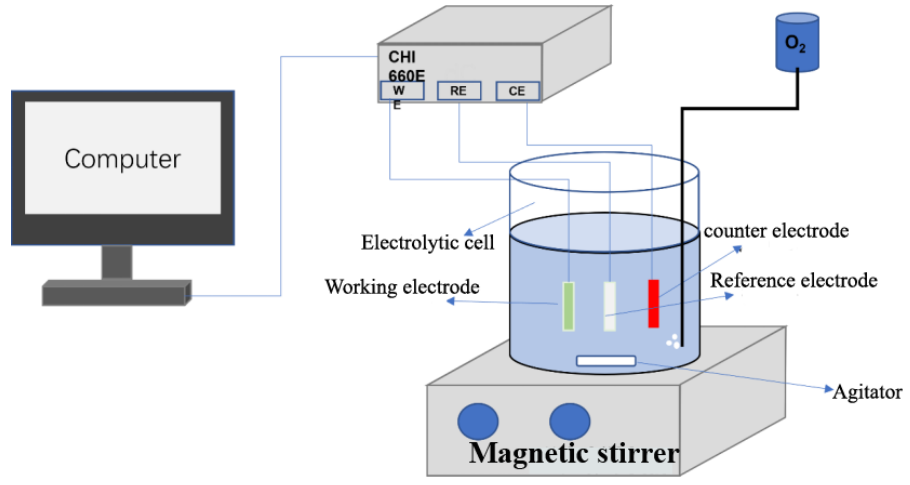
Figure 1. Schematic diagram of electro-Fenton experimental process.